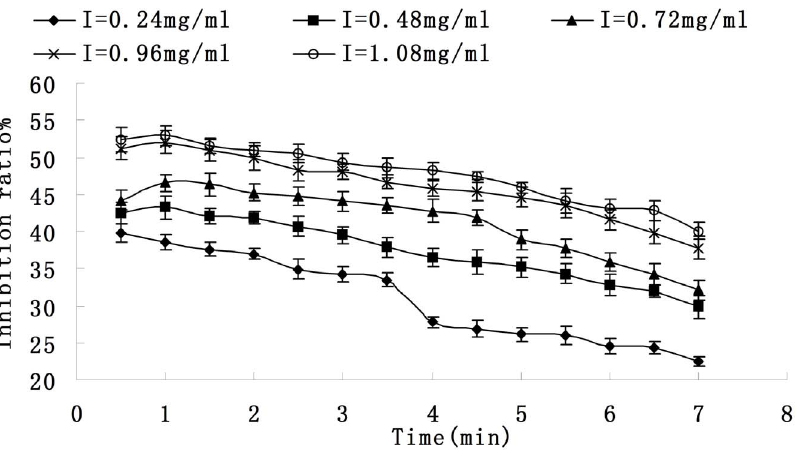
Figure 3. Relationship between reaction time and inhibitory effect on activity of tyrosinase. Each value is expressed as mean ± standard deviation (n=3).